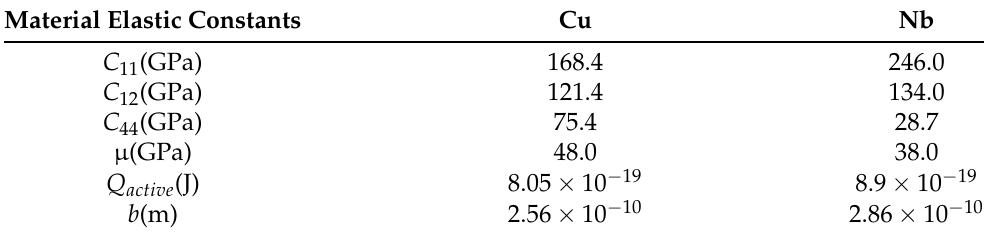
Table 2. Material constants of copper and niobium acquired from analytical processes and databases.